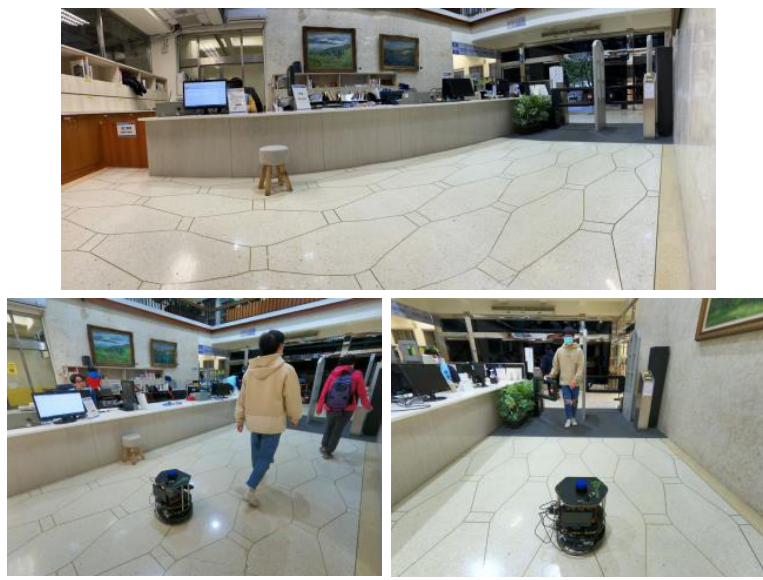
Figure 19. Indoor experimental environment (library).